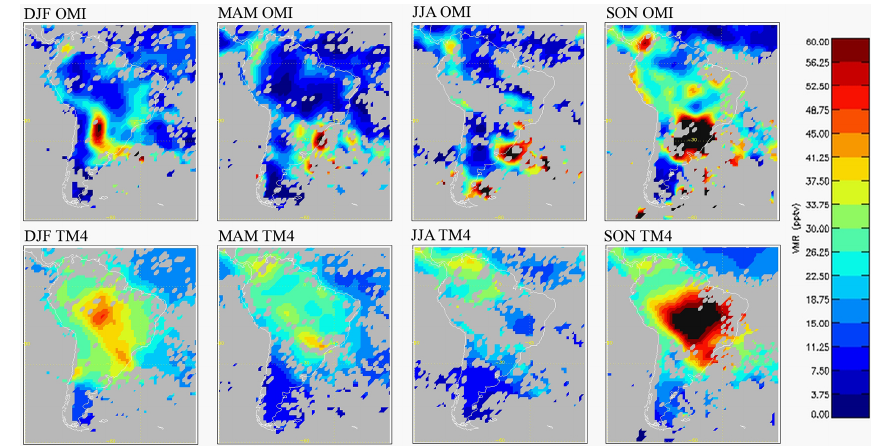
Figure 19. South American sector at 280hPa: seasonal variability in OMI (top row) versus TM4 model (bottom row) average NO 2 VMR pseudoprofiles for the year 2006.